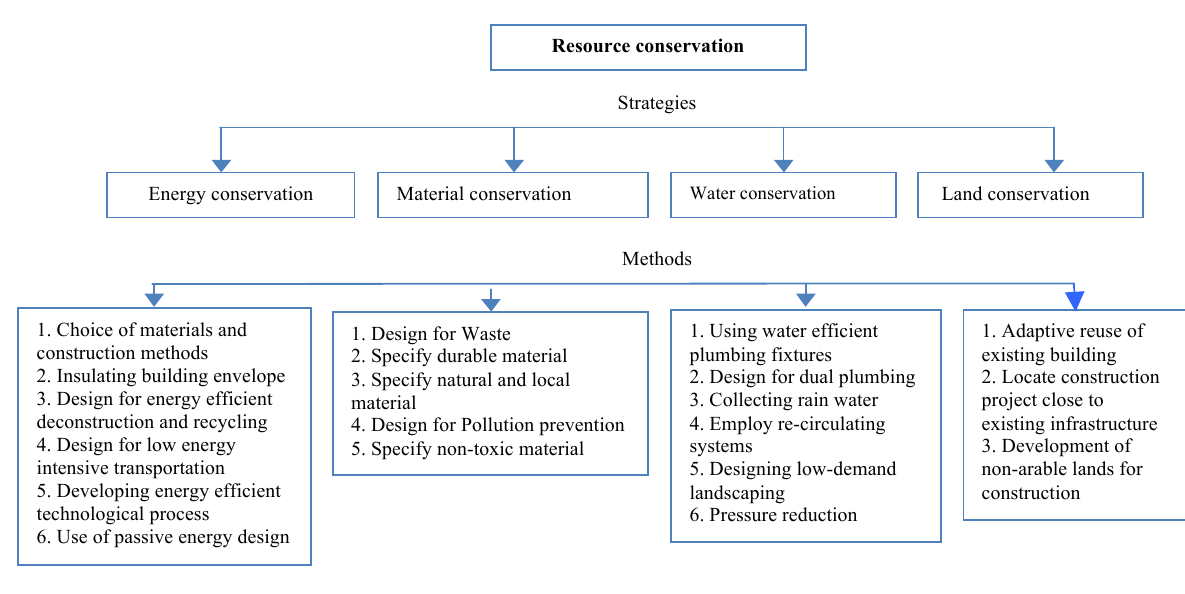
Figure 2. Strategies and Methods to achieve resource